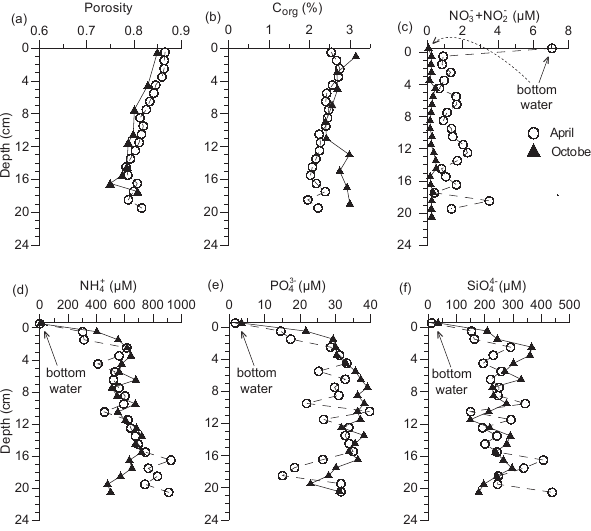
Figure 6. Seasonal variability in vertical profiles of (a) porosity, + NO − (b) sedimentary C org , (c) pore water NO − , (d) pore water 3 2 NH + , (e) pore water PO 3 − and (f) pore water SiO 4 − at station G5, 4 4 4 off Goa. The bottom water nutrient concentrations are pointed by arrow